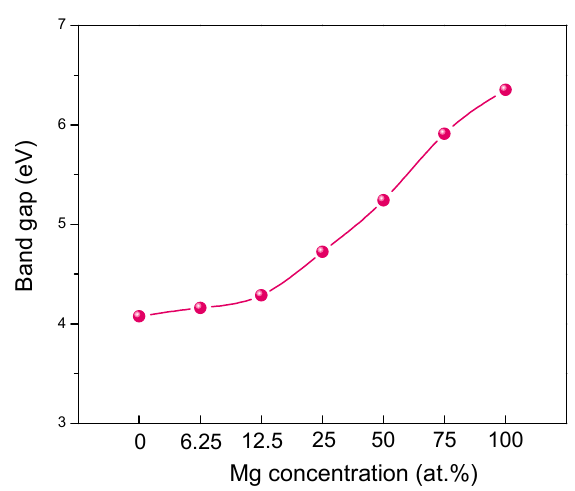
Mg concentration (at.%) Figure 4. The band gap of MgZnO monolayer versus Mg concentration.